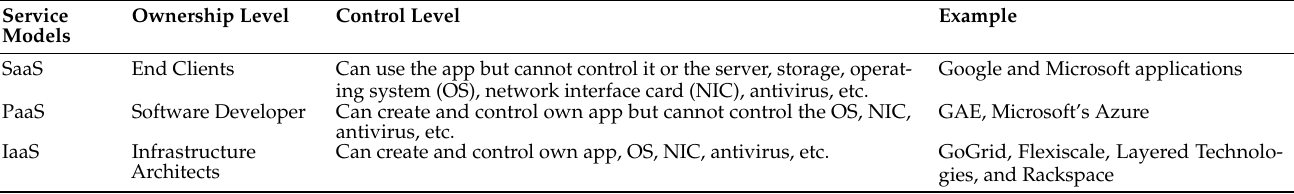
Table 1. Summary of CC service models.